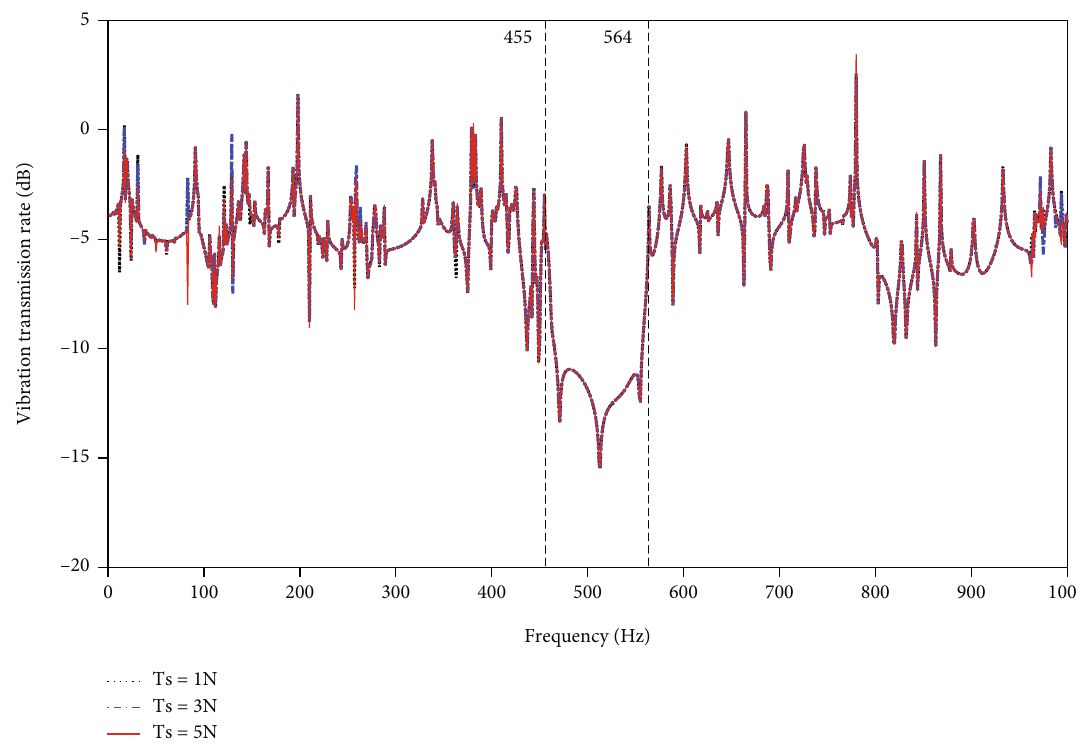
Figure 14: The vibration transmission rate of node R corresponding to the change of cable